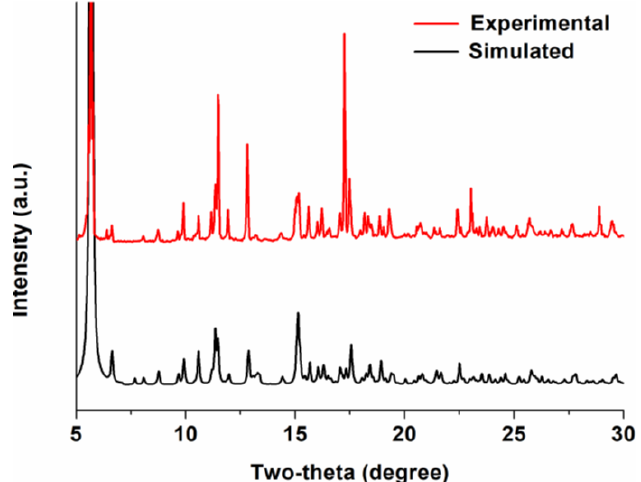
Figure 1. The powder X-ray diffraction patterns of MOF 1 , showing a good consistency between the experimental (red) and simulated (black) patterns and thus a high phase purity of the bulk material. The slight inconsistency in the intensity of some peaks might have been due to the di ff erent orientation of the crystallites in the sample, as the metal–organic framework (MOF) is non-merohedrally twinned.